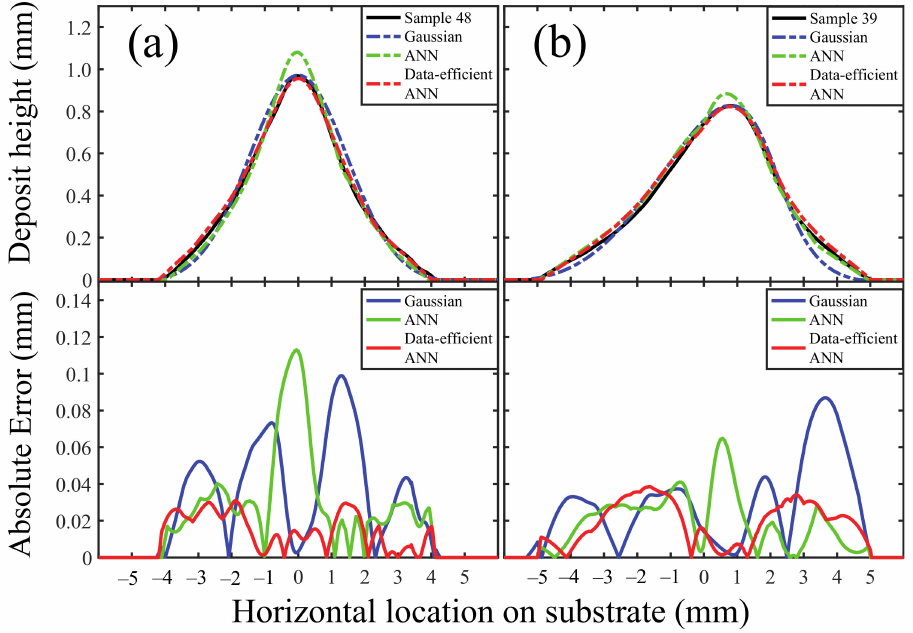
Figure 4. The experimental single-track profiles of the two selected profiles in the testing dataset as illustrative cases (black), plotted with the corresponding prediction results of the curve-fitted Gaussian function model (blue), purely data-driven ANN model (green) and the data-efficient ANN model (red): (a) Sample 48 (spray angle: 90 ◦ , traverse speed: 39 mm/s, standoff distance: 39 mm) and (b) Sample 39 (spray angle: 39 ◦ , traverse speed: 34 mm/s, standoff distance: 41